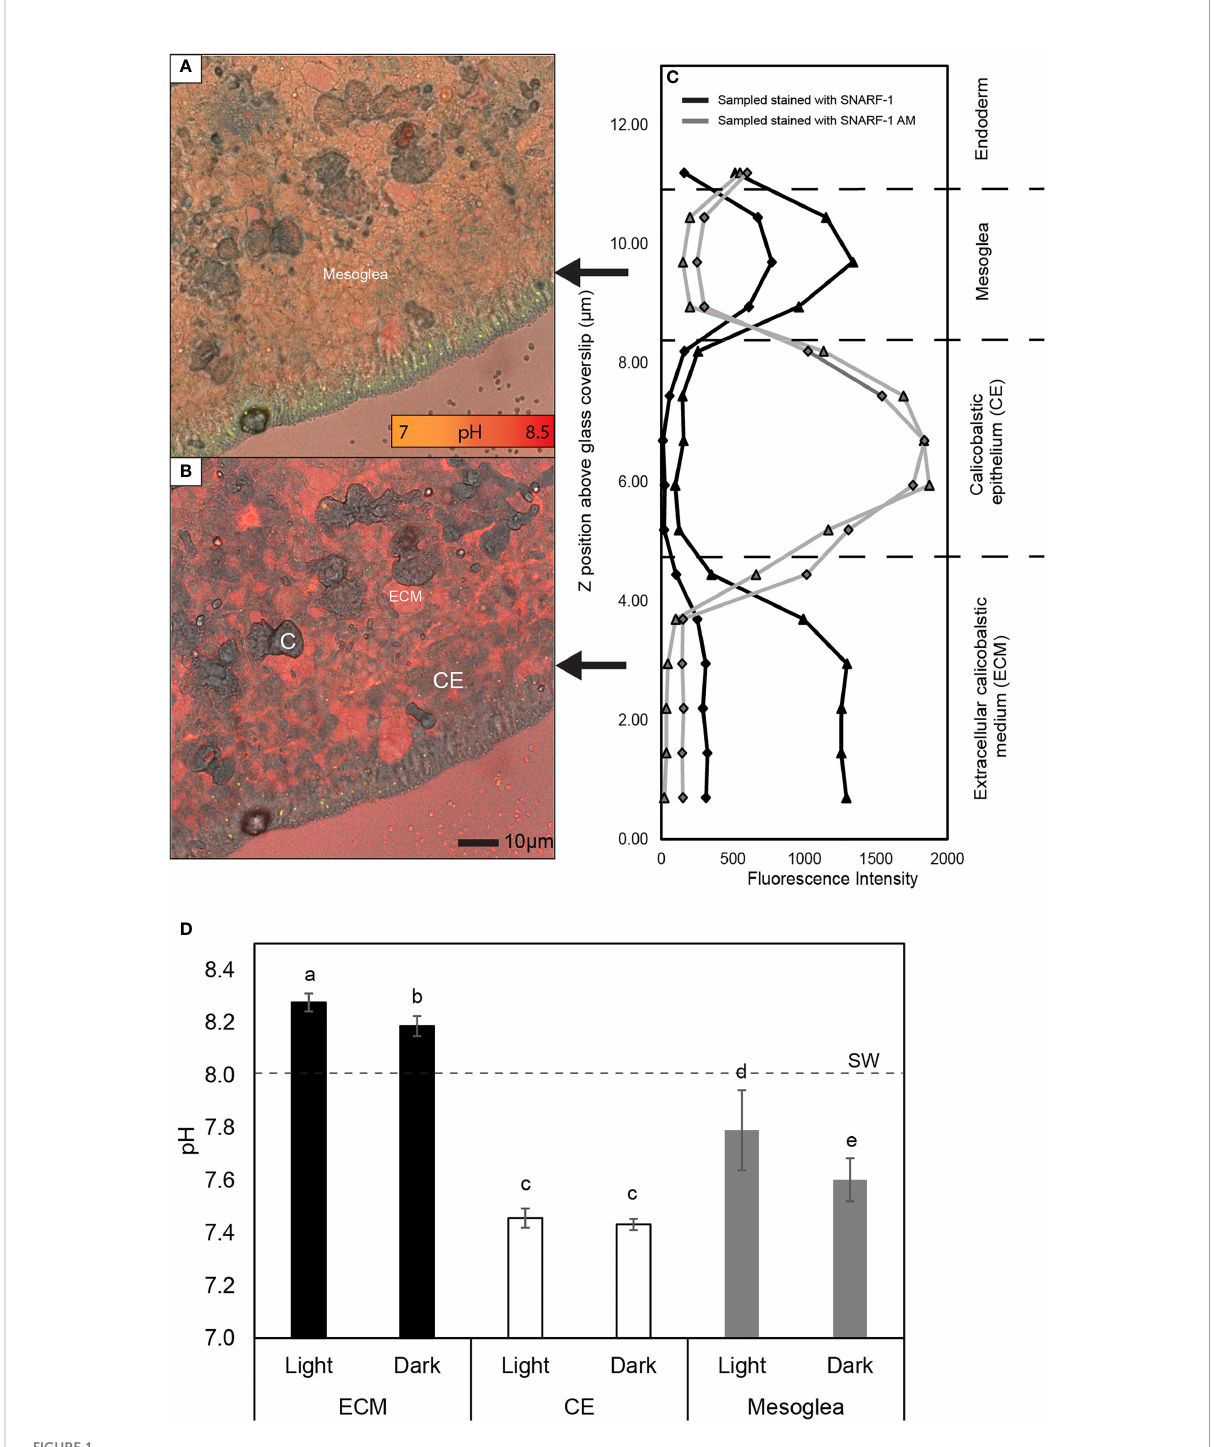
FIGURE 1 Analysis of the pH gradient across the calcifying epithelium of S. pistillata . (A, B) Examples of merged confocal and transmitted light images taken in the mesoglea (A) and the extracellular calcifying medium (ECM) (B) at 9 and 2 µm above the glass coverslip in a microcolony stained with cell impermeant SNARF-1. C = crystals and CE = calicoblastic epithelium. (C) Example of fl uorescence data obtained in separate Z stacks showing elevated fl uorescence of cell impermeant SNARF-1 in the ECM and mesoglea, and of cell permeant SNARF-1 AM in the CE. Triangle and diamond symbols indicate fl uorescence captured at 585 ± 10 and 640 ± 10 nm respectively. (D) Mean pH ± SD of the ECM, calicoblastic epithelium and mesoglea in light and darkness at seawater pH 8. SW= seawater pH. Letters above bars indicate signi fi cantly different groups determined by post hoc pairwise comparisons using Mann Whitney U